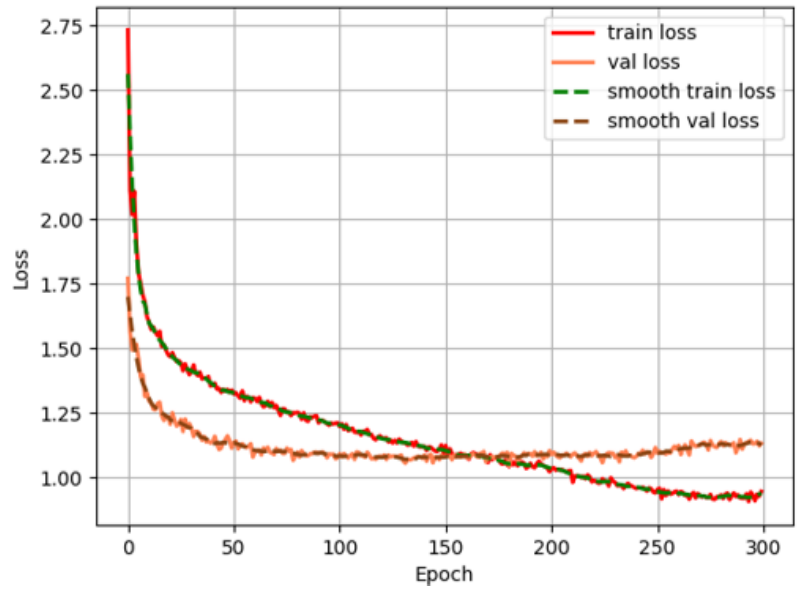
Figure 19. Change of loss value during